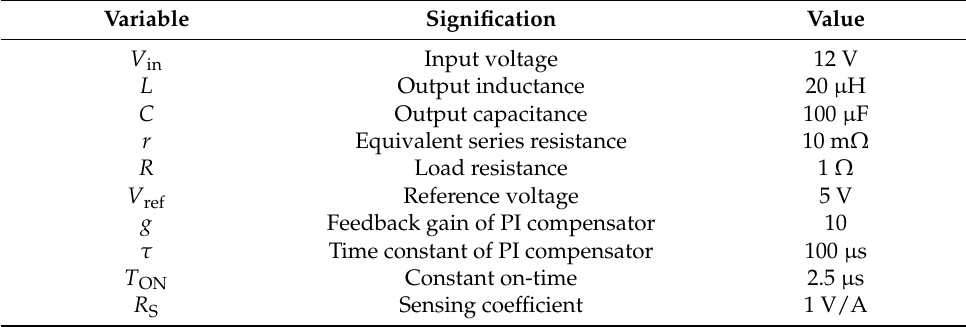
Table 1. Circuit parameters for the two COT controls.